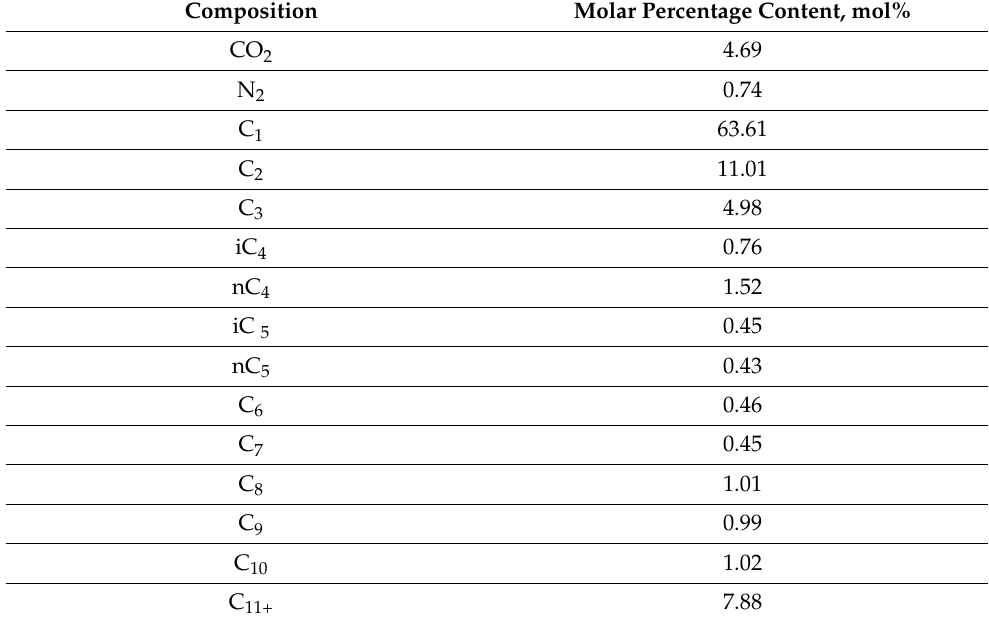
Table 1. Well stream composition for X well.